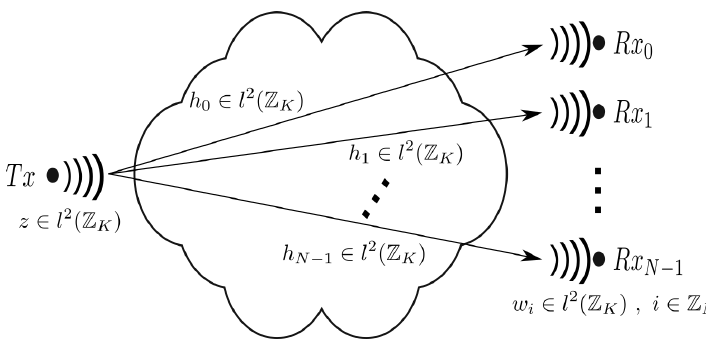
Figure 5. SIMO input/output channel